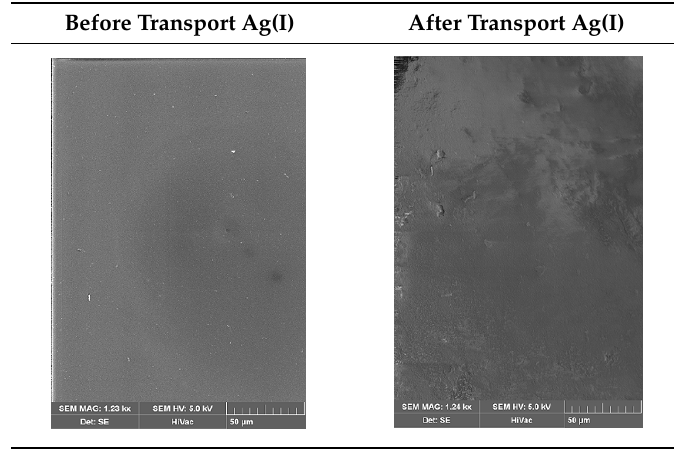
Table 2. SEM images before and after the transport of Ag(I) ions across a PIM containing KP (magnification 50 µm).